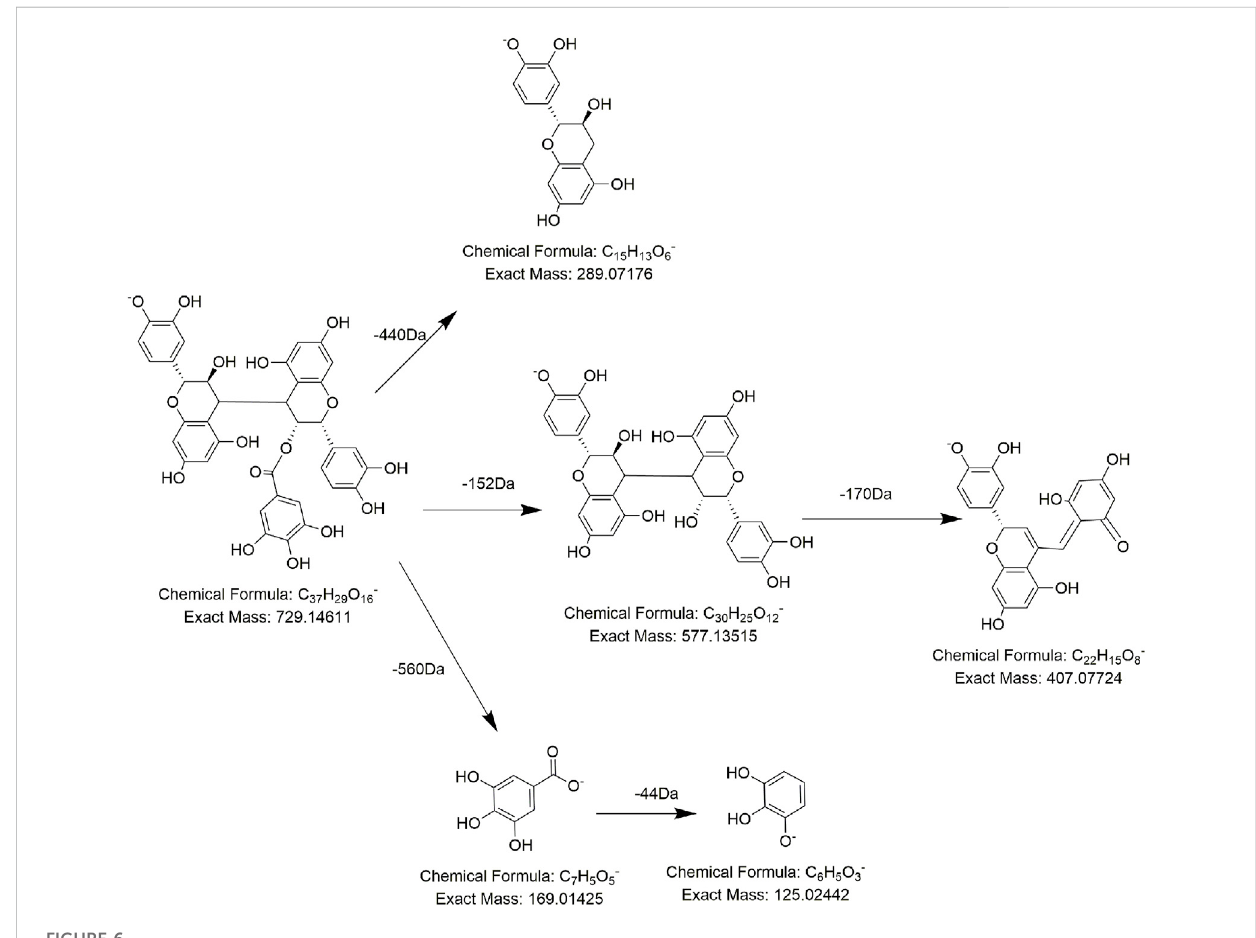
FIGURE 6 Proposed fragmentation pathways of FL5 (3-O-galloyl-procyanidin).